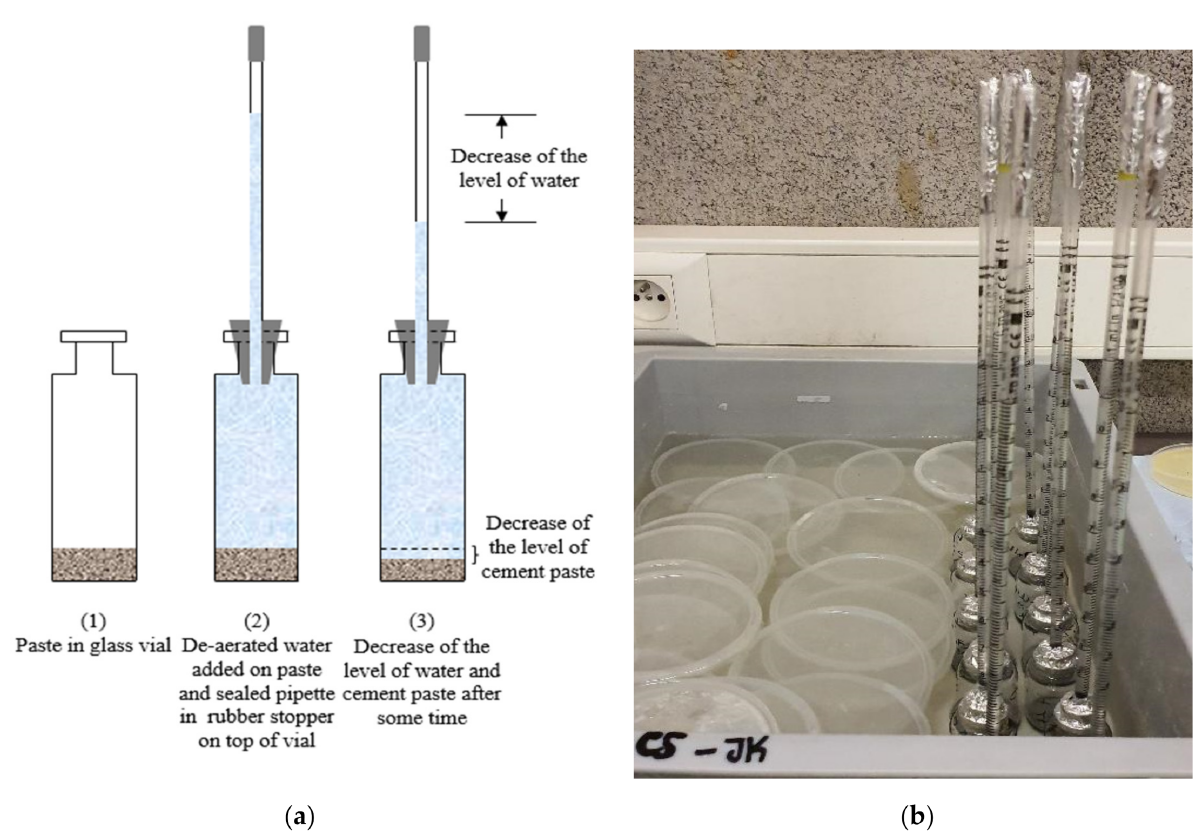
Figure 3. Test set up for chemical shrinkage: ( a ) schematic diagram, ( b ) samples in water bath at constant temperature (during the test the water bath is covered by lids to avoid